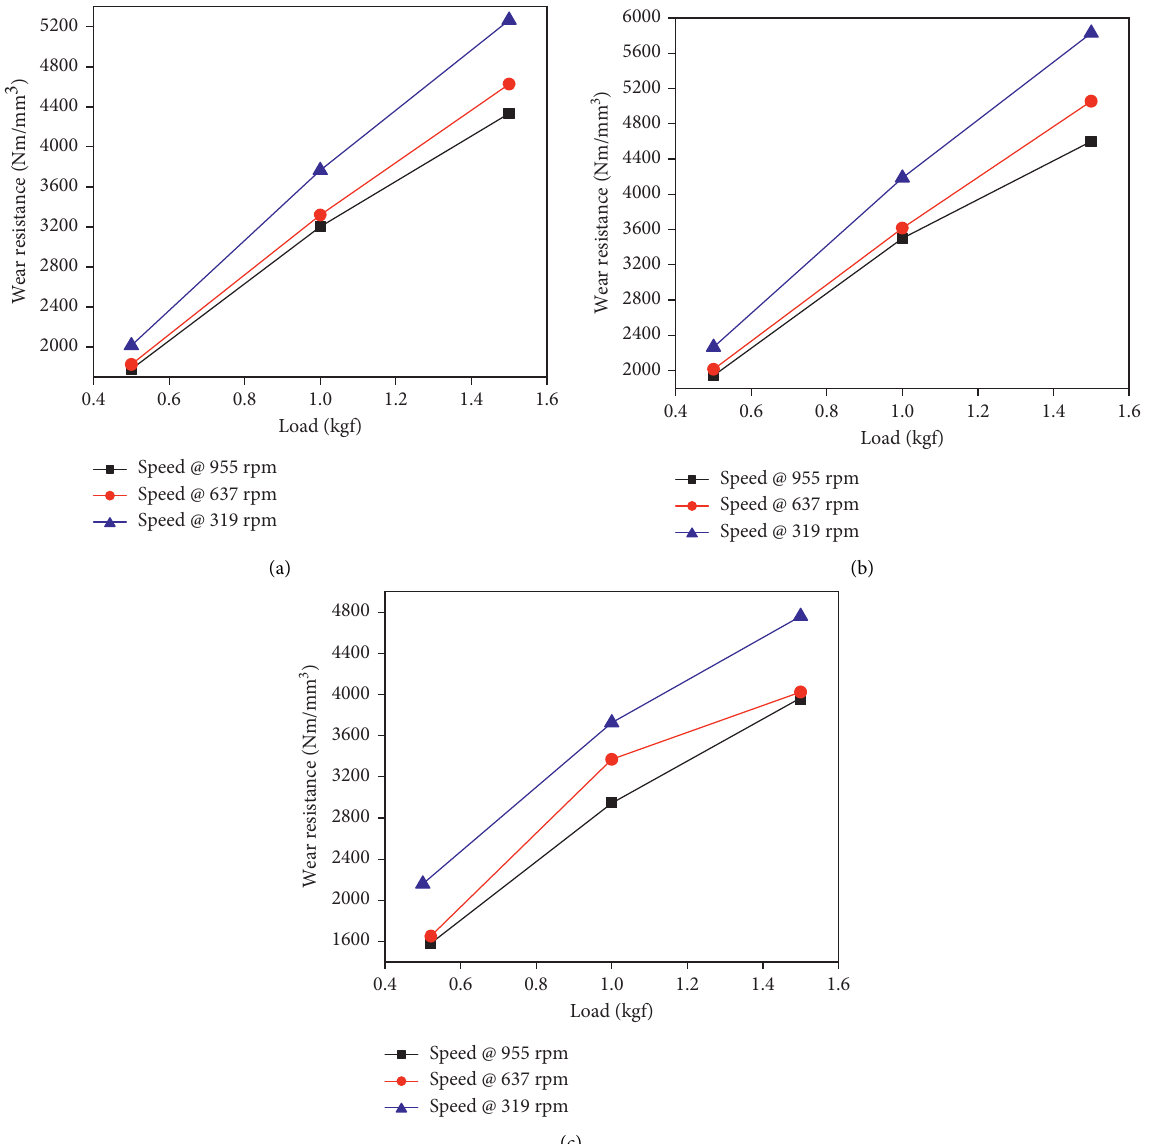
Figure 8: Calculated wear resistance for the test experiments on Al 2 O 3 +TiO 2 coatings for different rotational speeds: (a) Al 2 O 3 +TiO 2 +1% CNT, (b) Al 2 O 3 +TiO 2 +3% CNT, and (c) Al 2 O 3 +TiO 2 + 5%